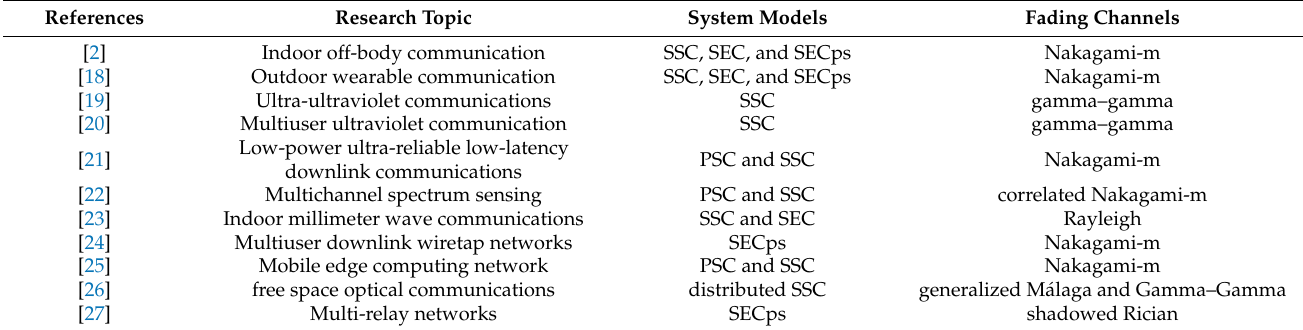
Table 1. A list of SDC schemes used in some emerging wireless communications